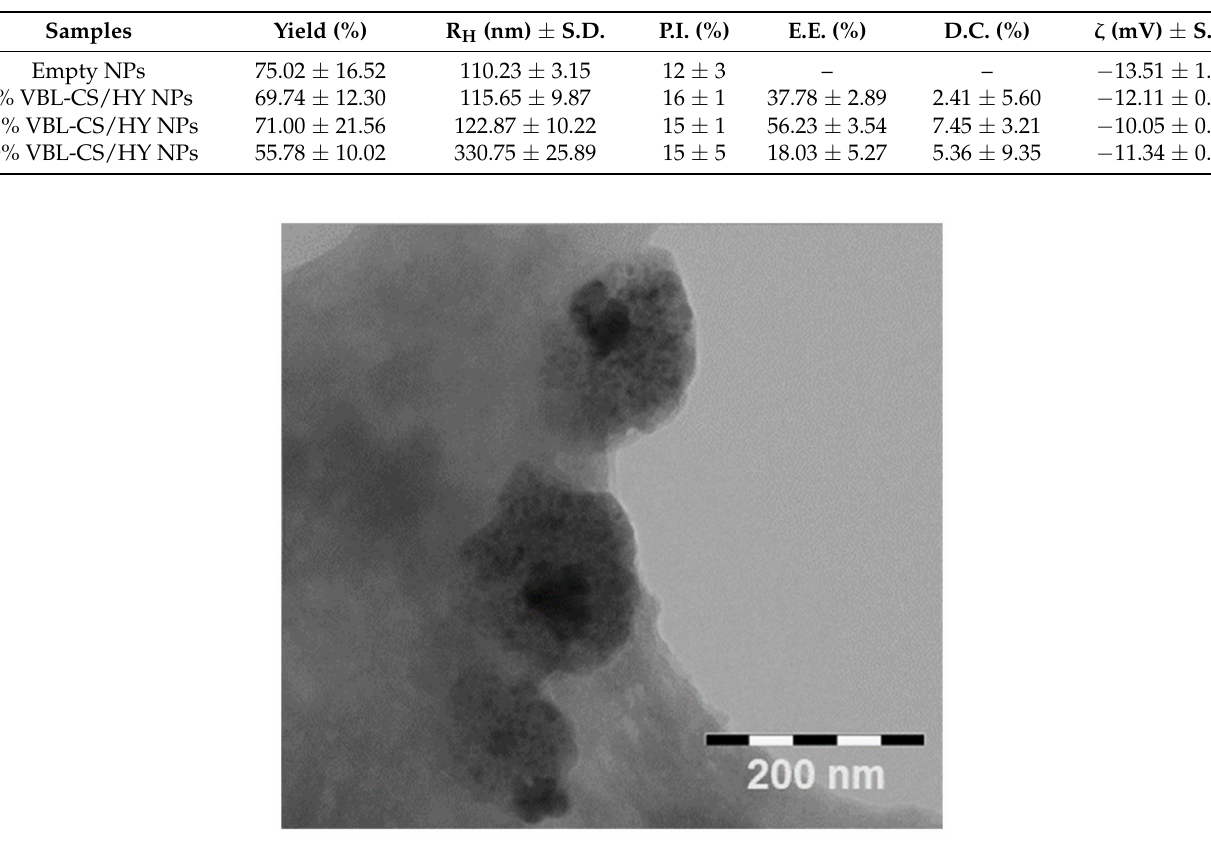
Figure 5. TEM picture of lyophilized 15% VBL-CS/HY